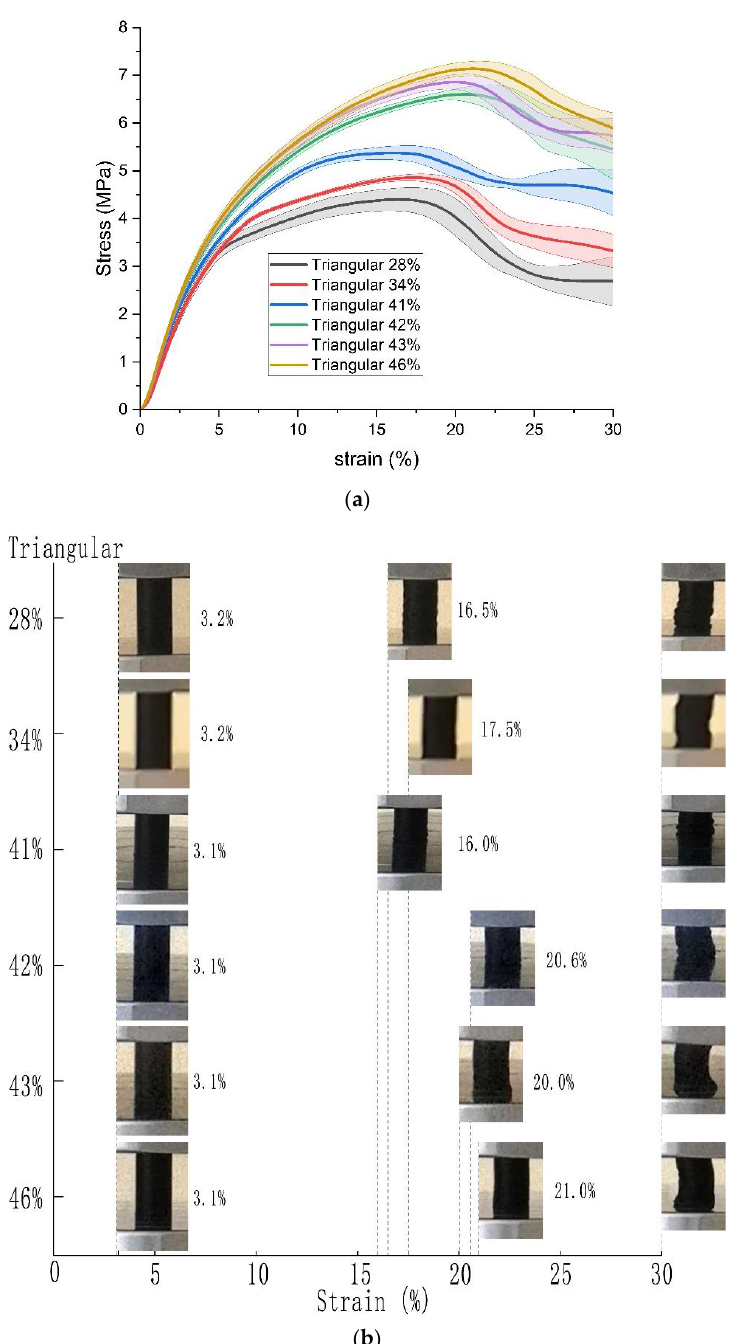
Figure 7. Results of Standard Specimens with triangular fill. ( a ) stress versus strain; ( b ) appearance.